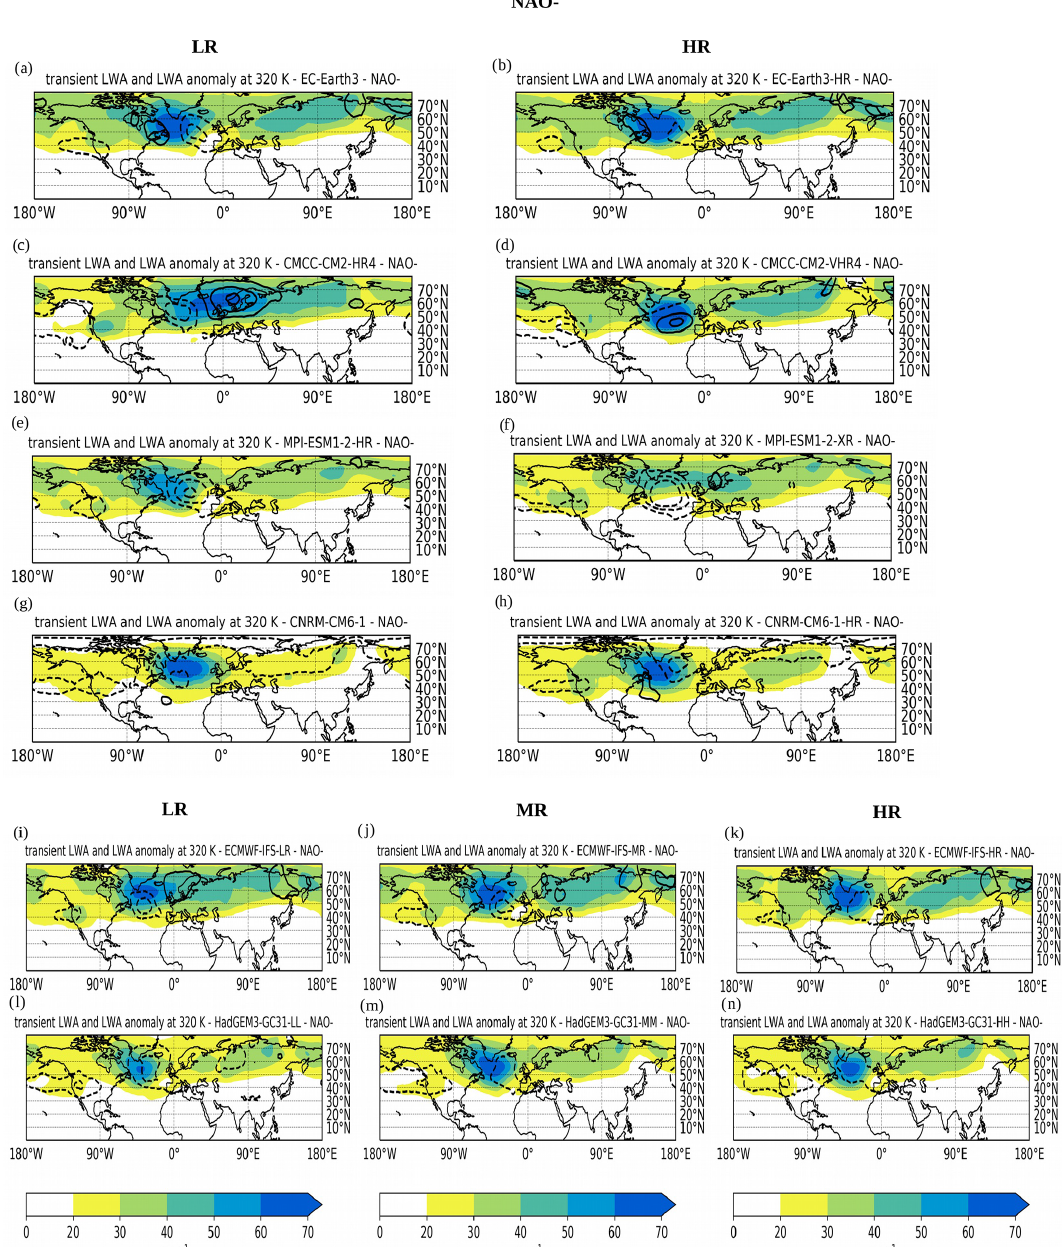
Figure 10. As in Fig. 8 but for NAO −